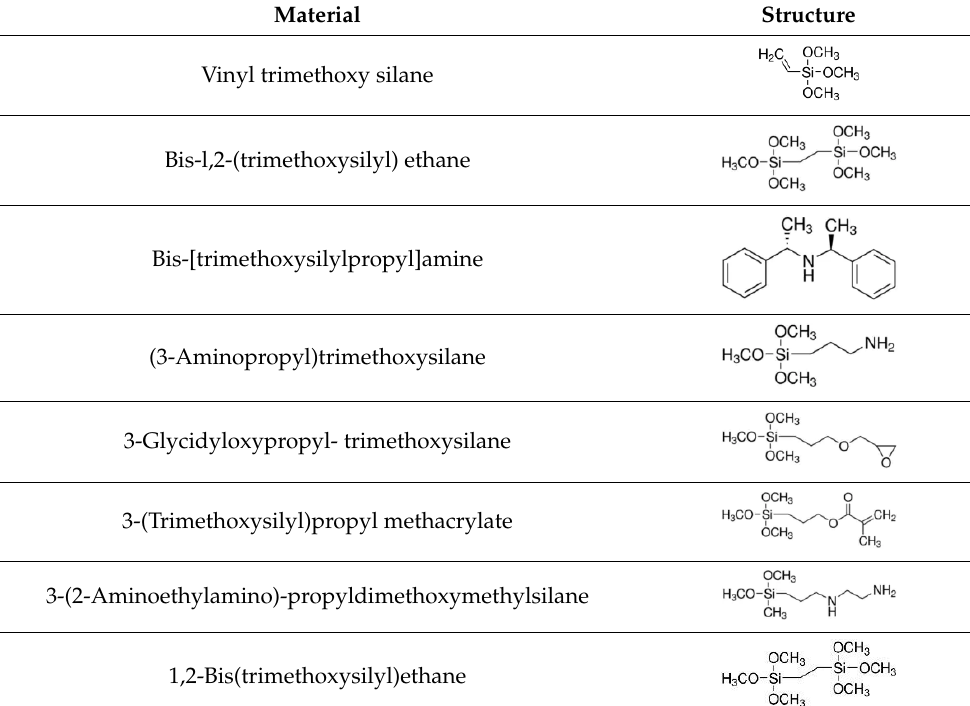
Table 1. The structures of some Table 1. The structures of some silanes/bis-silanes. Table 1. The structures of some silanes/bis-silanes. Table 1. The structures of some silanes/bis-silanes. Material Table 1. The structures of some silanes/bis-silanes. Table 1. The structures of some silanes/bis-silanes. Table 1. The structures of some silanes/bis-silanes. Table 1. The structures of some silanes/bis-silanes. Table 1. The structures of some silanes/bis-silanes.